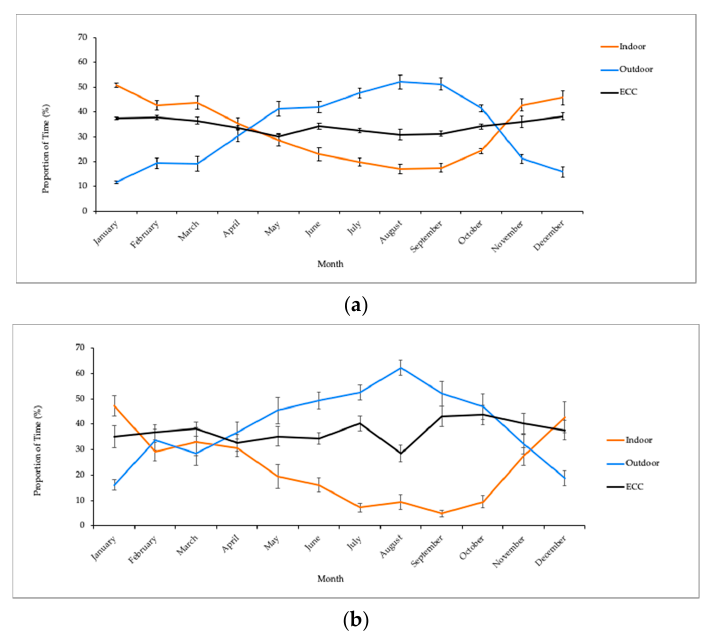
Figure 7. Mean (% ± standard error) monthly proportion of time in habitat use by the Smithsonian National Zoo’s elephant herd, recorded using ( a ) the 24 h closed circuit observation method or ( b ) ZooMonitor 30 min focal observations. Indoor monthly total proportion of time represents time that the elephants spent in suites 1–7. Outdoor is the monthly total proportion of time spent in habitats a–d. “ECC” refers to the Elephant Community Center, a large indoor space that opens up to habitat b. Animals 2020 , 10 , x